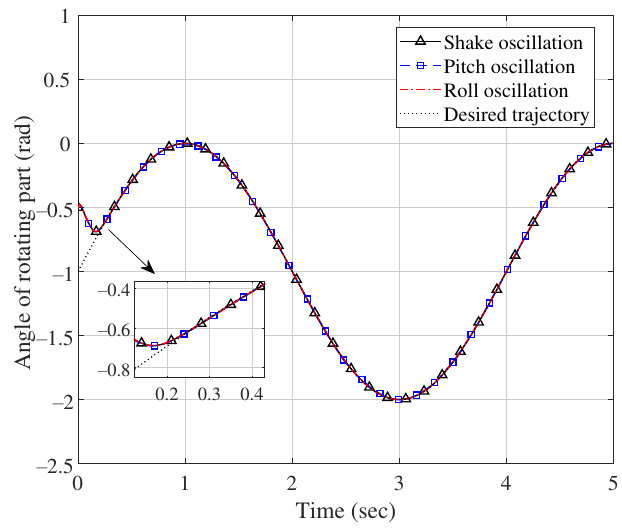
Figure 8. Position of lifting part (Group 1).